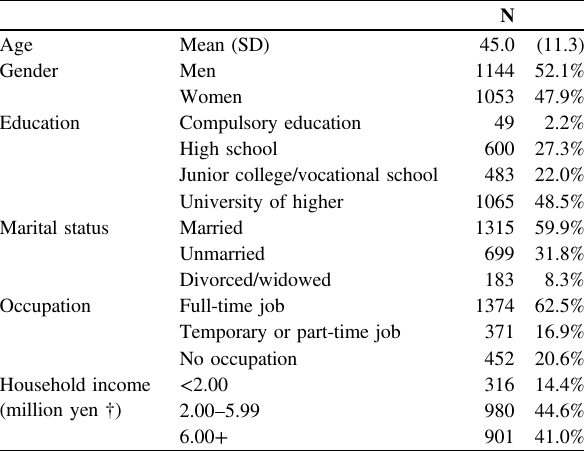
Table 1 Characteristics of the study